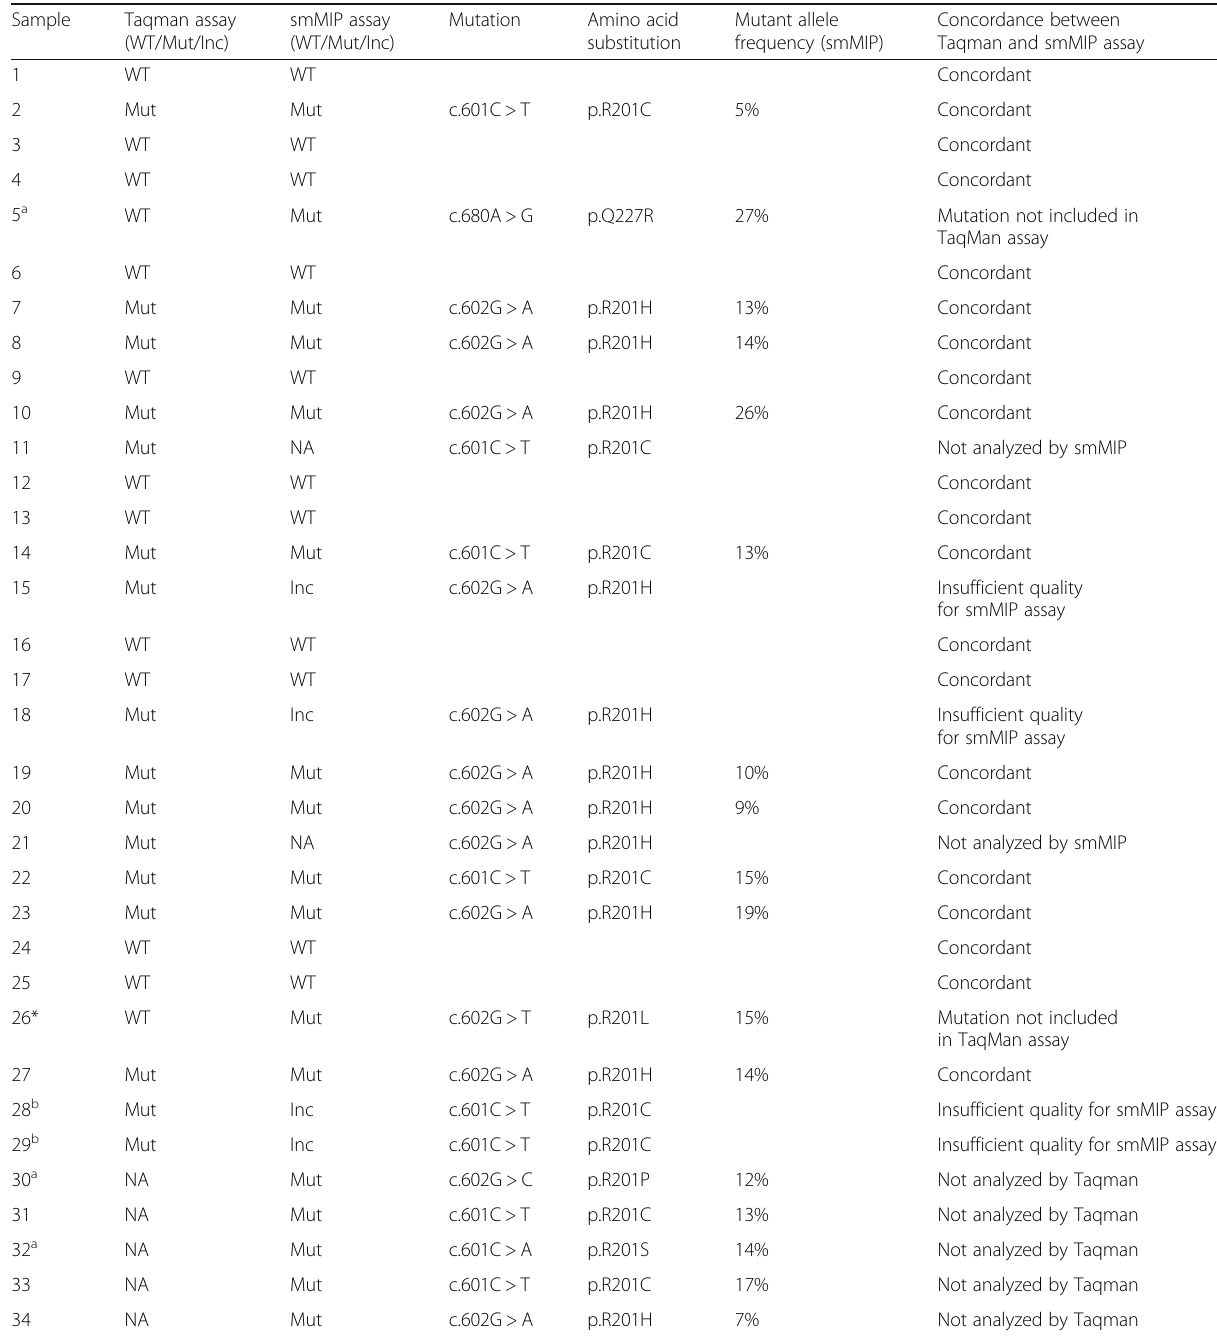
Table 3 Mutation analysis intramuscular myxoma